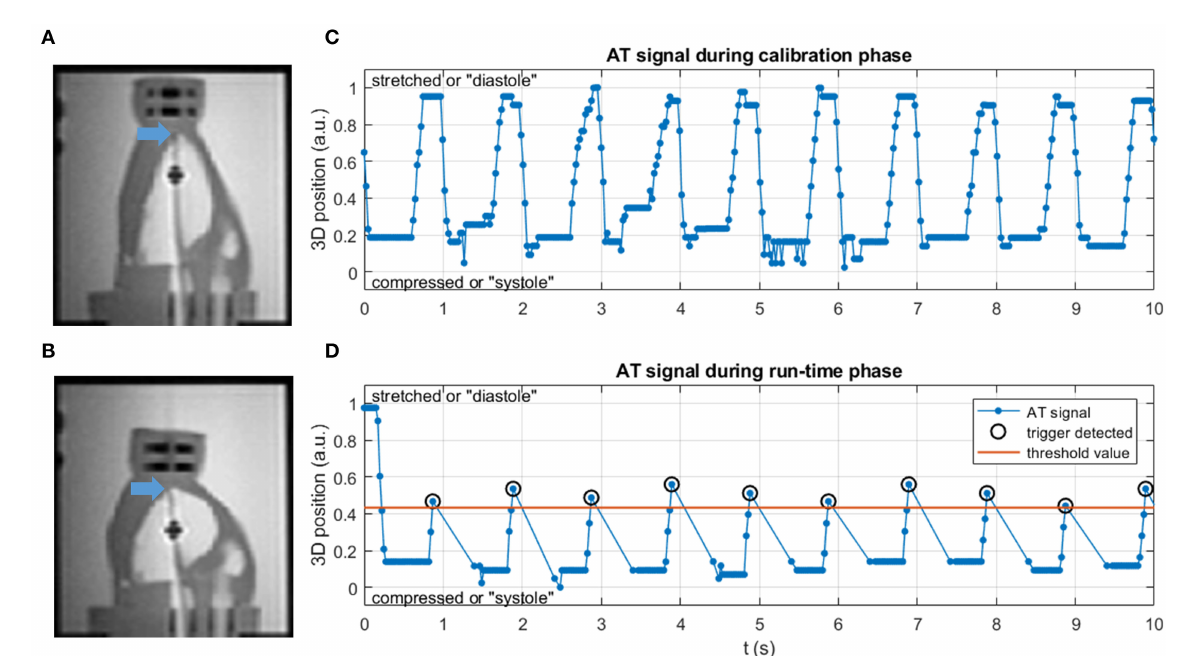
FIGURE2 (A,B) Coronal MR images of the phantom setup in (A) stretched (diastole) and (B) compressed (systole) state. Blue arrows mark the catheter tip at the apex of the LV. (C) AT signal in the calibration phase is uninterrupted and with a periodicity of 60 BPM. (D) AT signal in the run-time phase, with triggers at appropriate motion states and at regular intervals. After each trigger an absence of AT signal is seen, during which the thermometry images were acquired following a trigger delay.